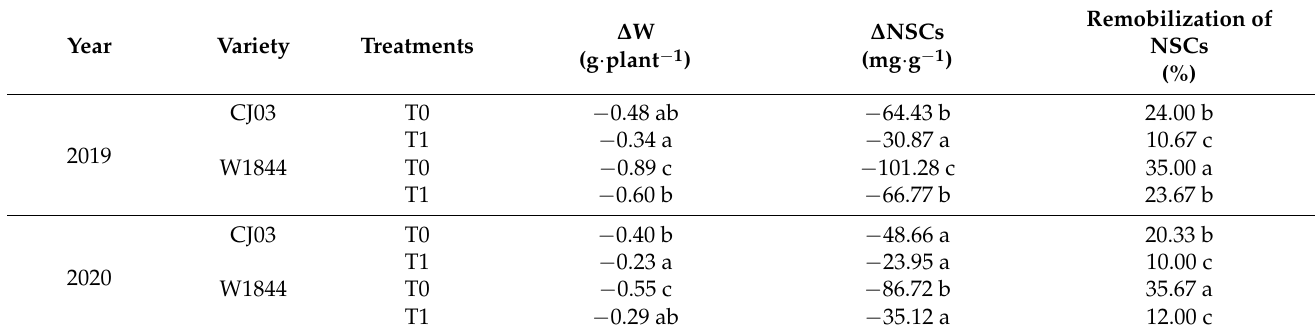
Table 3. Changes in DM and NSCs’ accumulation from 8 DPA to 20 DPA.